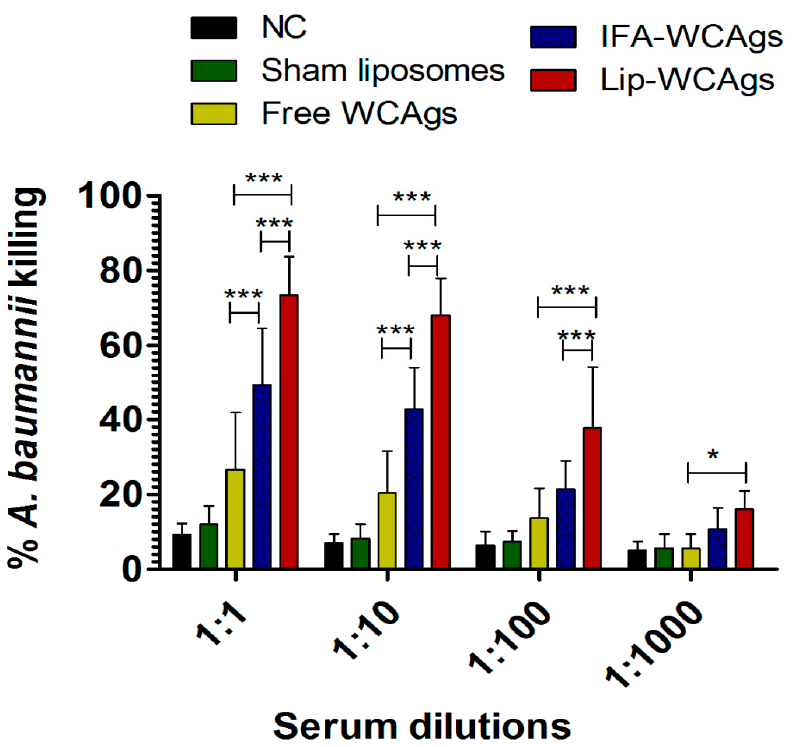
Figure 5. Antiserum from Lip-WCAgs-immunized mice showed the highest bactericidal activity against A. baumannii . The antiserum was diluted with a culture medium and mixed with macrophages and bacteria for one hour. The aliquots (10 µ L) were taken and plated on TSB plates to determine the numbers of CFUs. The data are mean ± SD of three different experiments. *** p < 0.001, * p < 0.05.